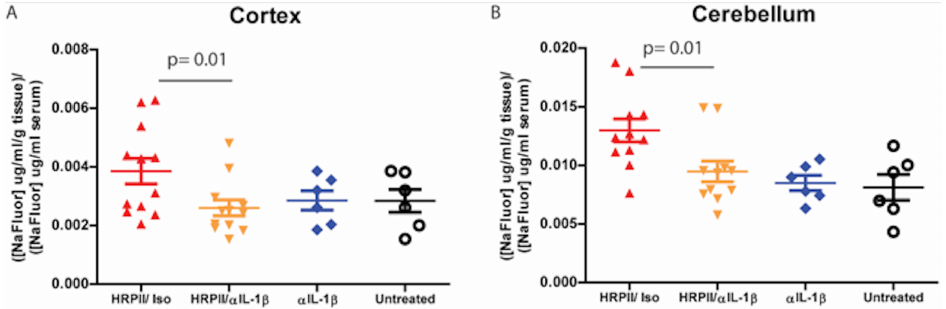
Fig 2. HRPII-mediated vascularleakag e is blocked by antibody to IL-1 β . Mice were infused as in Fig 1, with HRPII plus an isotype antibody (Iso, positive control), HRPII plus anti-IL-1 β antibody (experimental condition) or anti-IL-1 β antibody alone (negative control). Untreatedmice (no HRPII, no antibody)served as a further control. Vascular leakagein mice infusedwith HRPII/isotype is statistically significantly different from mice infusedwith HRPII/ anti-IL-1 β ,p = 0.01 (cerebellum) and p = 0.01 (cortex), by two-tailedt-test; p = 0.003 (cerebellum) and p = 0.06 (cortex) by ANOVA one-wayvariancewith significancebetweenHRPII/isotype and HRPII/ anti-IL-1 β .Data are mean values +/-SEM for 6–12 mice per group accumulatedover 3 independent experiments.